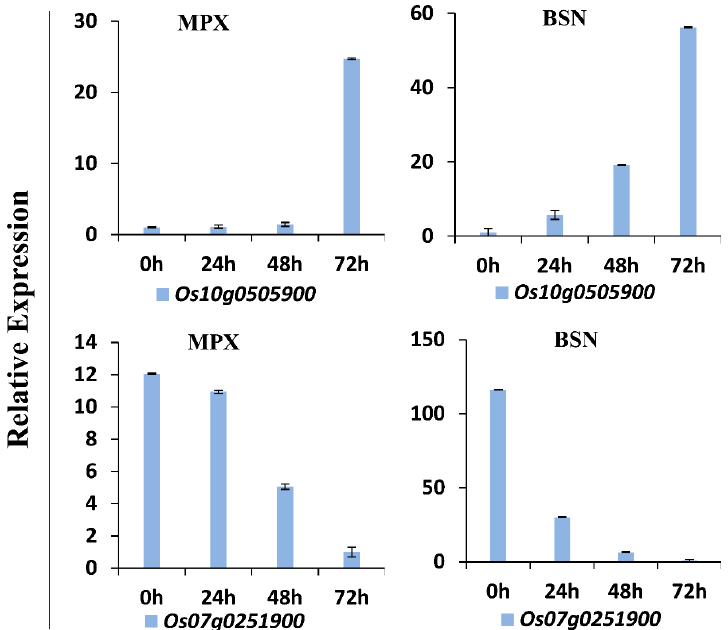
Figure 7. Expression characteristics of two selected unigenes of PEG ‐ treated plants at 0 h, 24 h, 48 h, and 72 h. The relative expression value was calculated using the 2 −ΔΔ Ct